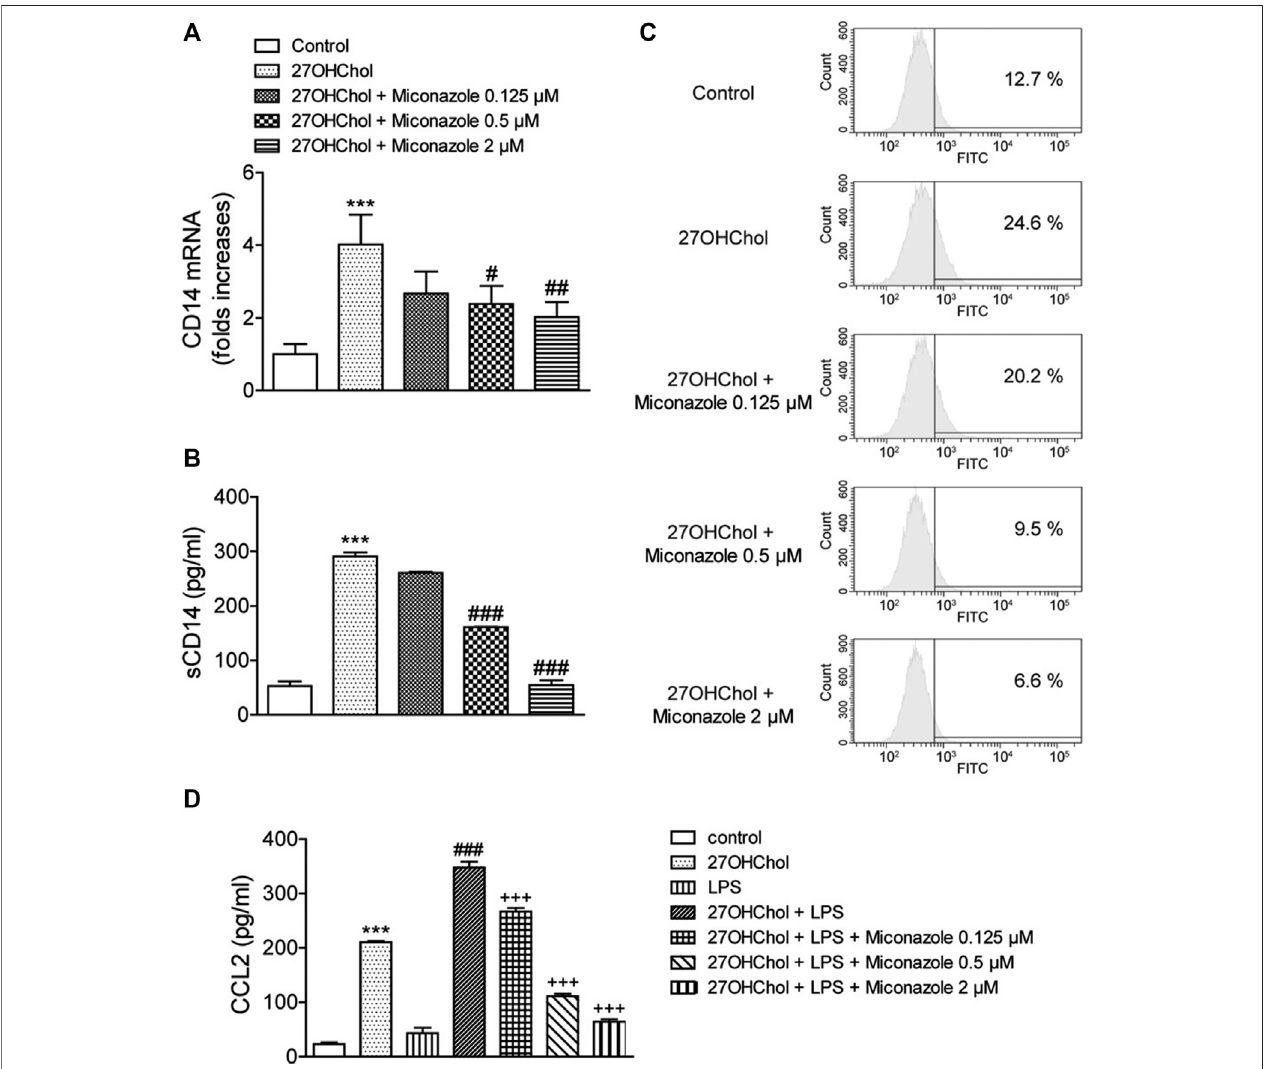
FIGURE 2 | Miconazole downregulates CD14 expression, thereby weakening the LPS response. THP-1 cells (2.5 × 10 5 cells/ml) were cultured for 48 h with 27OHChol (2 μ g/ml) in the presence of indicated miconazole concentrations. (A) CD14 transcript levels were assessed via quantitative reverse transcription-PCR, and (B) theamountofsCD14proteinsecretedintothemediumwasmeasuredwithELISA.Resultsarerepresentativeofthreeindependentexperiments.Dataareexpressed as mean ± standard deviation (SD) ( n (cid:2) 3 replicates for each group). *** p < 0.001 vs control; ### p < 0.001 vs 27OHChol; ## p < 0.01 vs 27OHChol; # p < 0.05 vs 27OHChol. (C) THP-1 cellsimmunostainedwithsurface CD14wereanalyzed via fl owcytometry.Dataarerepresentative ofthreeindependentexperiments. (D) Serum- starved THP-1 cells (2.5 × 10 5 cells/ml) were cultured for 24 h with 27OHChol (2 μ g/ml) in the presence of the indicated concentrations of miconazole, followed by stimulation for 9 h with or without LPS (100 ng/ml) obtained from Escherichia coli K12. Culture media were isolated, and the amount of CCL2 protein secreted into the media was measured using ELISA. Results are representative of three independent experiments. Data are expressed as mean ± SD ( n (cid:2) 3 replicates for each group). *** p < 0.001 vs control;### p < 0.001 vs 27OHChol;+++ p < 0.001 vs 27OHCholplusLPS.27OHChol,27-hydroxycholesterol;LPS,lipopolysaccharide;sCD14,soluble CD14.